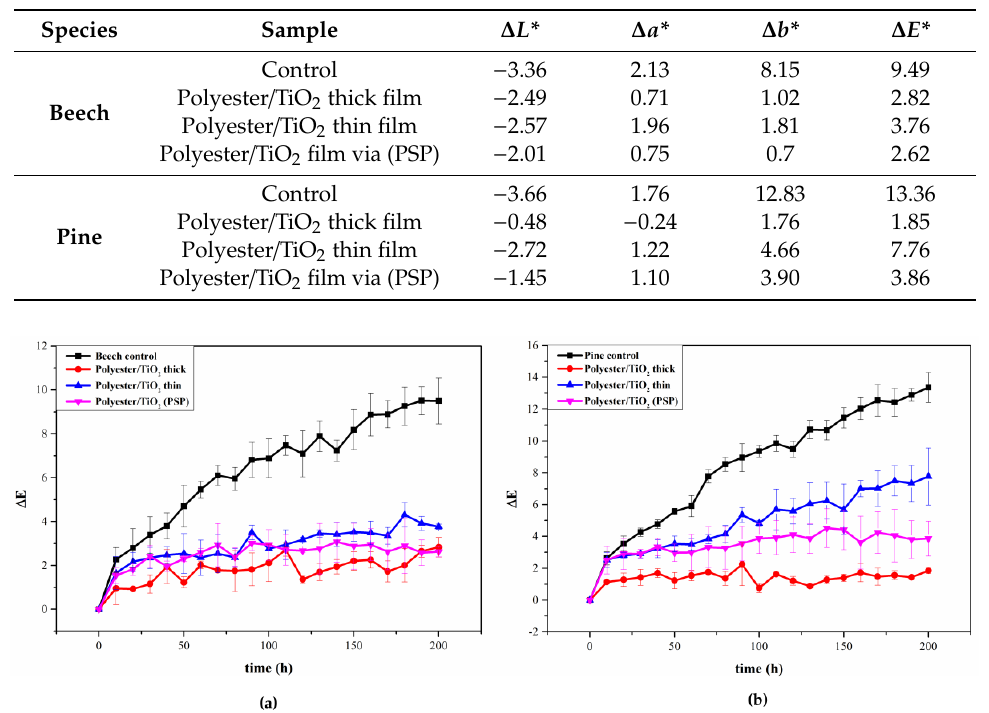
Table 4. Di ff erences in colour measurements before and after 200 h exposure to UVA radiation.